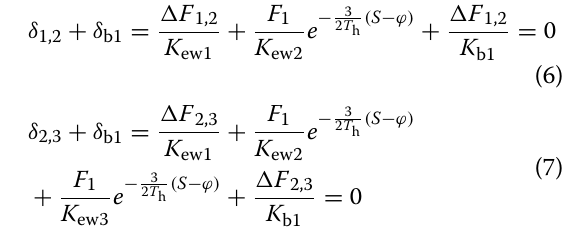
Table 4 List of axial bolt force ratios after tightening all bolts ( T T h S [mm]